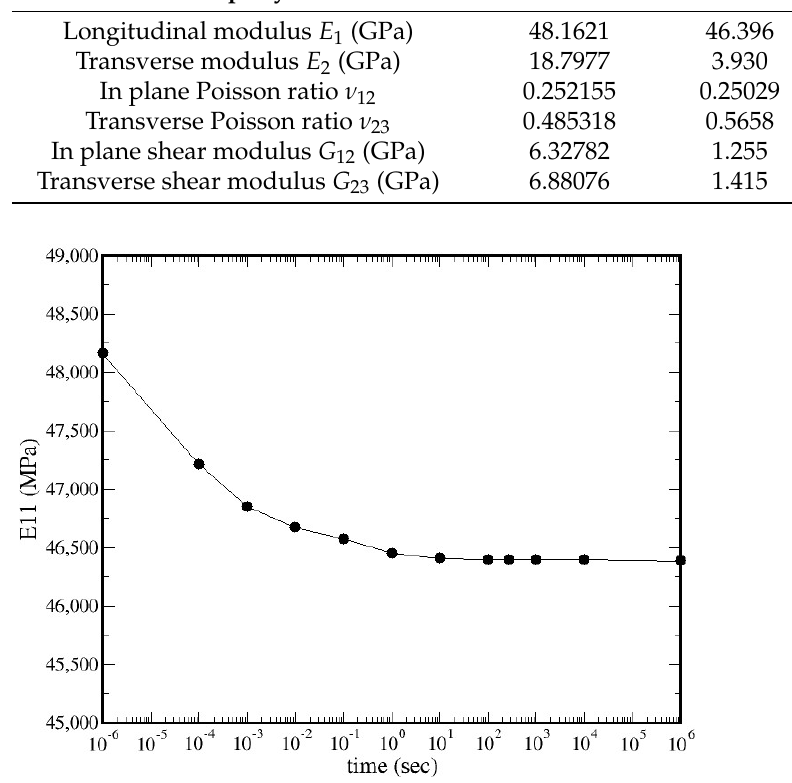
Figure 2. Time dependent homogenized axial Young’s modulus E 11 from viscoelastic